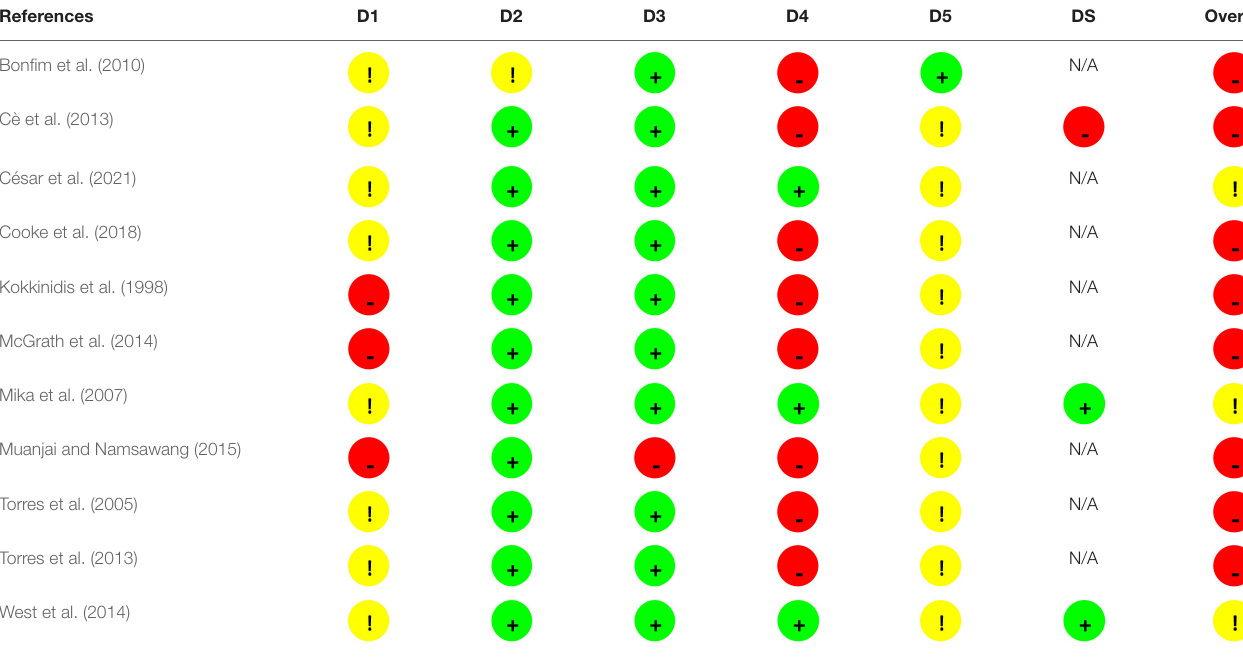
TABLE 3 | Risk of bias in individual studies (worst-case